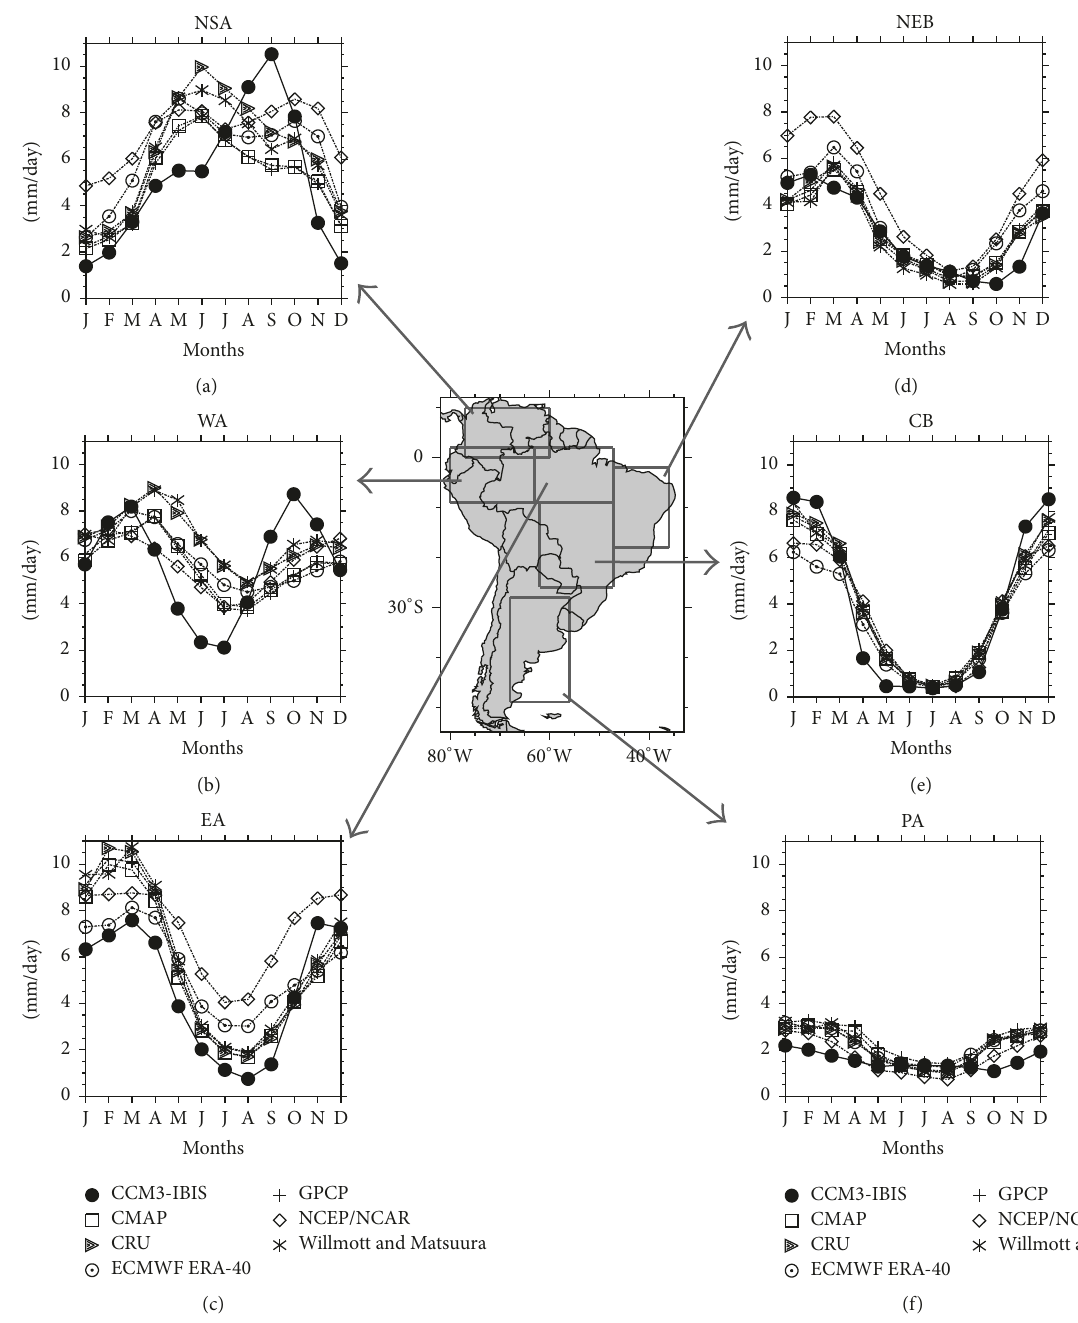
Figure 1: Seasonal cycle of precipitation climatology for the North of South America (a), West Amazonia (b), East Amazonia (c), Northeast Brazil (d), Central Brazil (e), and Patagonia (f). Individual data sources (various markers; see legend). Boxes indicate the regions as defined for this analysis in the period of